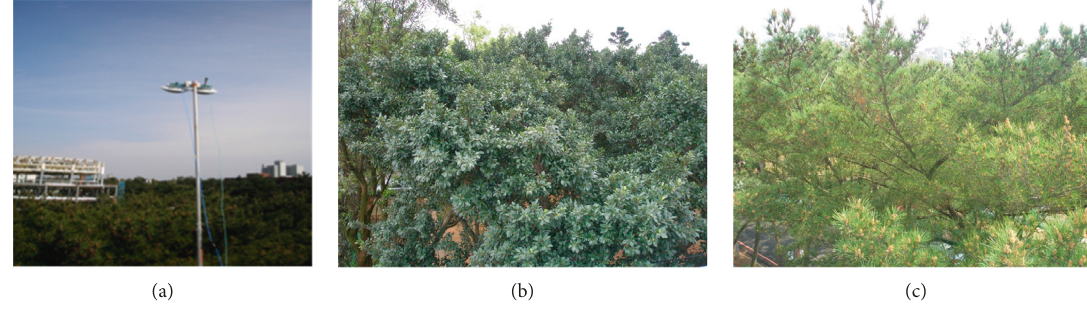
Figure 5: Radar measurement of the tree canopy: (a) photo of the pole-mounted transmitter; (b) a banyan tree; (c) a pine Table 3: Geometric parameters of the banyan and pine trees. Parameter